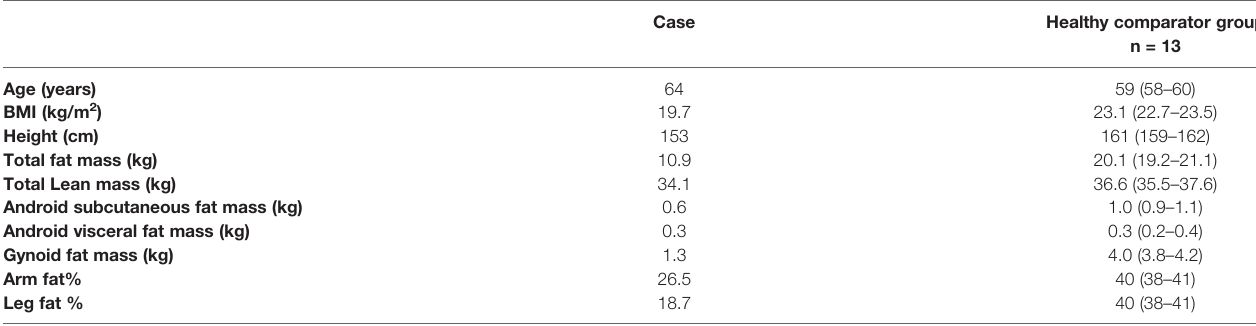
TABLE 1 | Regional body fat content in the